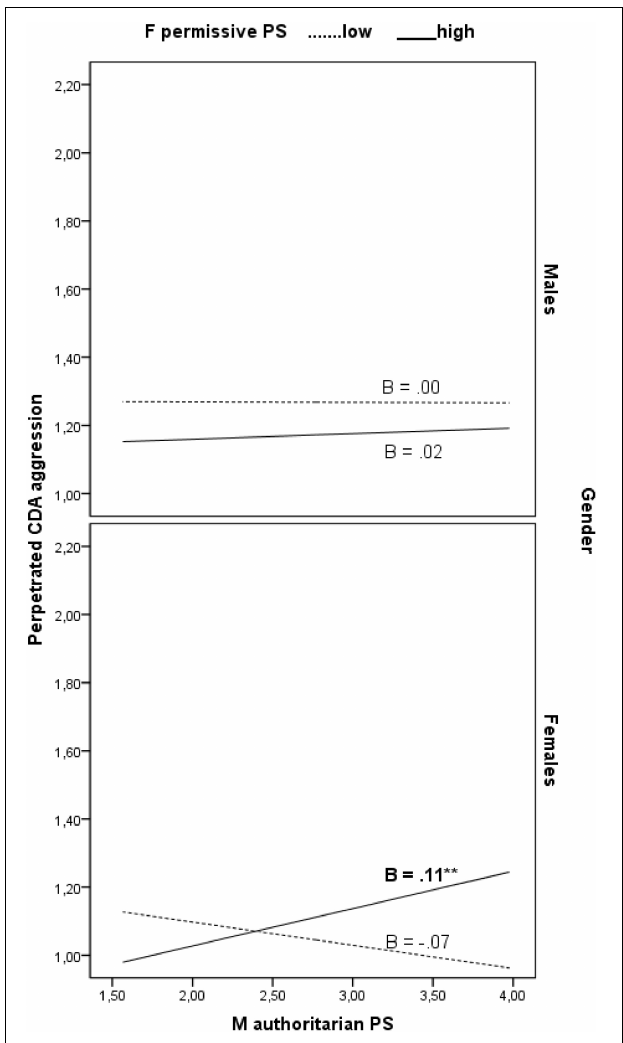
FIGURE 1 | The conditional effects of mother authoritarian parenting style on perpetrated cyber dating aggression as a function of father permissive parenting style and child gender. ** p < 0.01. M, mother; F, father; PS, parenting style; CDA, cyber dating